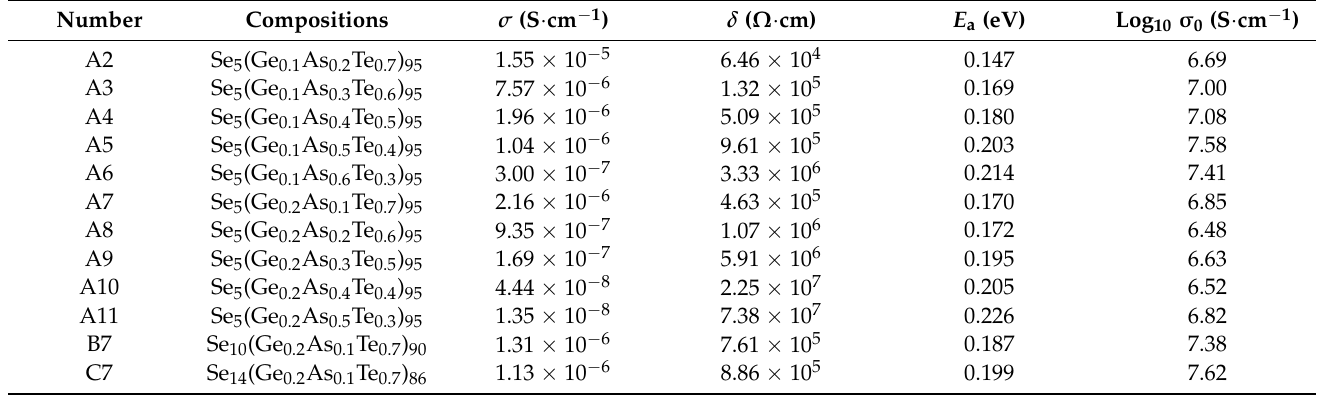
Table 2. Electrical conductivities σ , resistivity δ , activation energy E a , pre-exponential factor σ 0 of A2–A11, B7, and C7 glasses (T = 293